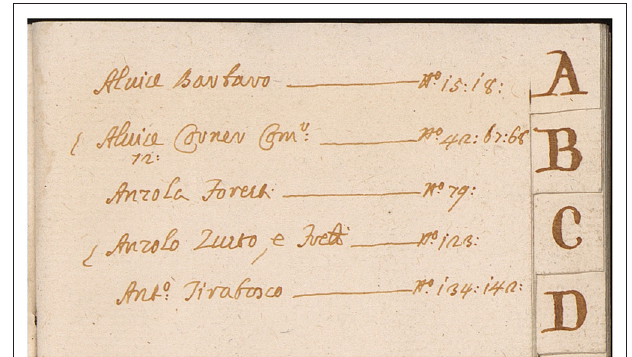
FIGURE 5 | A set of entries in an index of the Catastici . The first row refers to “Alvise Barbaro” who has two references, 15 and 18. From: State Archive of Venice, X Savi alle decime in Rialto , Catastici delle parrocchie , 1740, San Maurizio , f. 434, c.